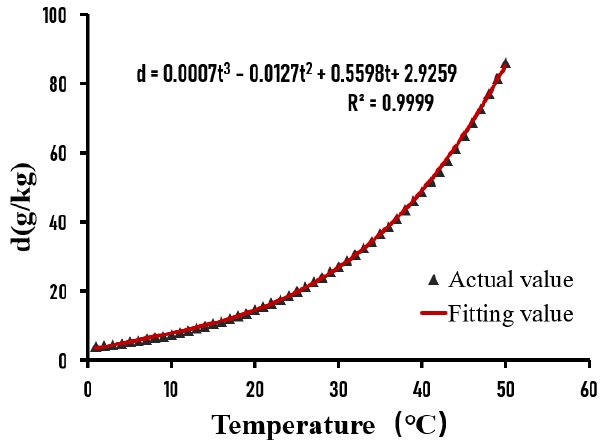
Figure 11. Functional relationship between temperature and the humidity